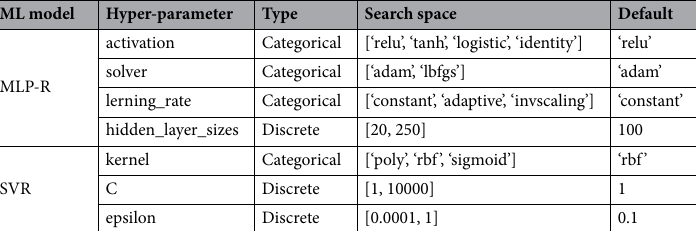
Figure 9. (a) MLP-R with four hidden network having different weights, where input layer ∈ R 4 1 layer ∈ R , output layer ∈ R and n1, n2, n3, and n4 represent the number of perceptron in each hidden layer, respectively. (b) HPO for GS, RS and GA with cross-validation, training the ML models with the tuned HP and prediction.